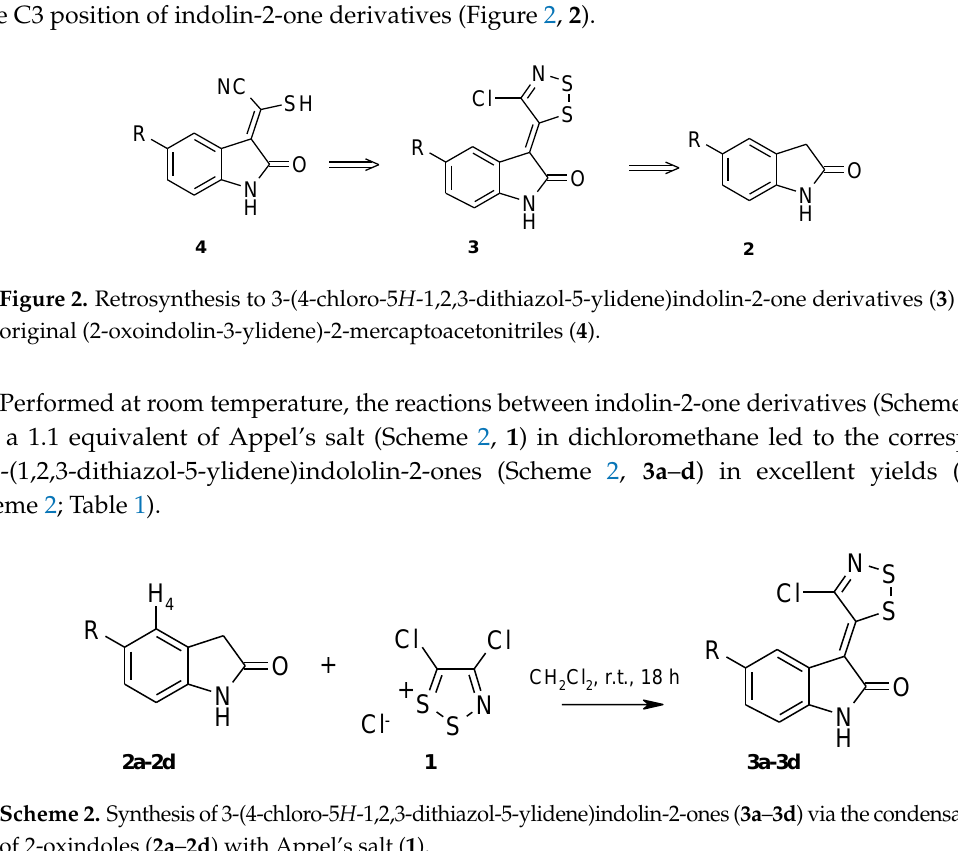
Table 1. Synthesis of 3-(1,2,3-dithiazol-ylidene)indolin-2-ones ( 3a – d ) from indolin-2-ones ( 2a – d ) with Appel’s salt (1.1 equivalent).